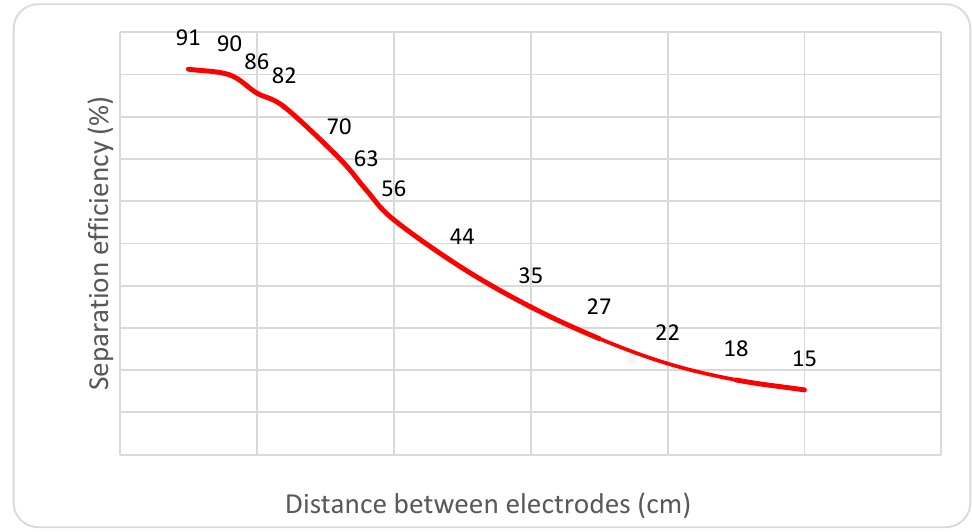
Figure 10. Graphical dependence of separation efficiency on the distance between electrodes. Smaller pipe diameters allow the use of lower high voltage, which allows the use of smaller and less expensive high voltage sources with reduced energy consumption. This was also proved by our measurements in which the first stronger source during operation at a voltage level of 60 kV consumed approximately 50 W during the measurements. The weaker model at a voltage level of 20 kV consumed only 25 W. At the same time, redistributing the flue gas flow into a larger number of pipes further increased the cross- sectional area from 0.0314 m 2 to 0.0452 m 2 , which further reduced the particle velocity rate. The turbulent flow caused by changing the cross-section of the pipe also helped to slow the velocity of the flowing particles